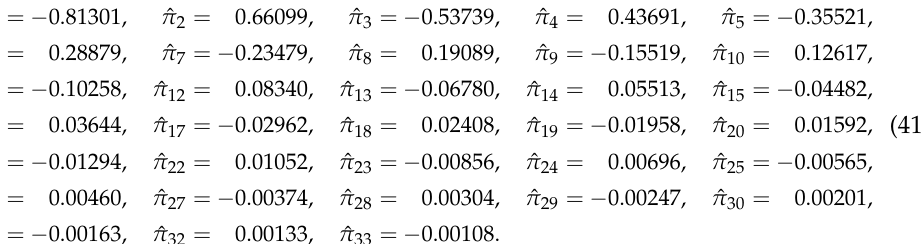
Using the AR-sieve technique presented in Step 3, we compute the empirical distri- bution function ˆ F n ( ˜ e t ) of the centered residuals ˜ e t . The S-like shape of ˆ F n ( ˜ e t ) in Figure 3 is the typical pattern of zero-mean Gaussian white noise. We remark that other AR approxi- mation conditions, τ = 0.1, 0.01, and 0.0001, are also investigated. The centered residuals for τ = 0.0001 depict a similar pattern to τ = 0.001, while the two other conditions do not. Thus, we only consider τ = 0.001 as a predetermined positive value close to zero.